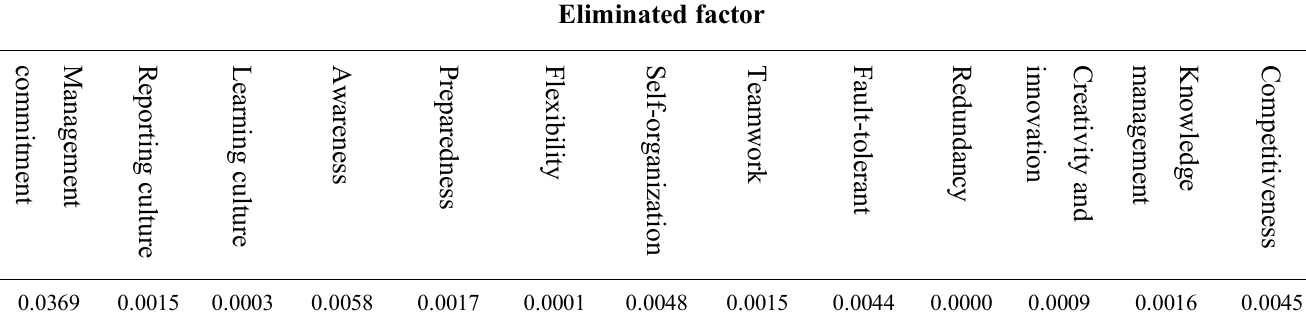
Table 4. Difference between average efficiency before and after factor elimination Eliminated